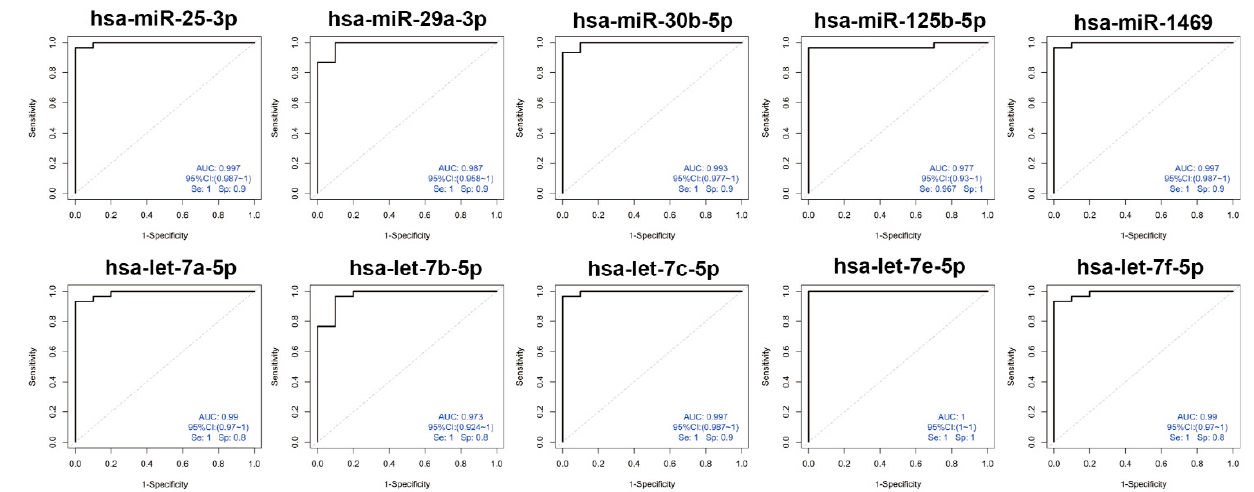
Figure 4. Receiver operating characteristic (ROC) analyses of differentially expressed miRNAs in TDs and controls. The 10 ROC curves show the ROC and AUC scores for the top ten dysregulated miRNAs. Upper panel: upregulated has-miR-25-3p, has-miR-29a-3p, has-miR-30-5p, has-miR-125b-5p, has-miR-1469. Lower panel: downregulated has-let-7a-5p, has-let-7b-5p, has-let-7c-5p, has-let-7e-5p, has-let-7f-5p.